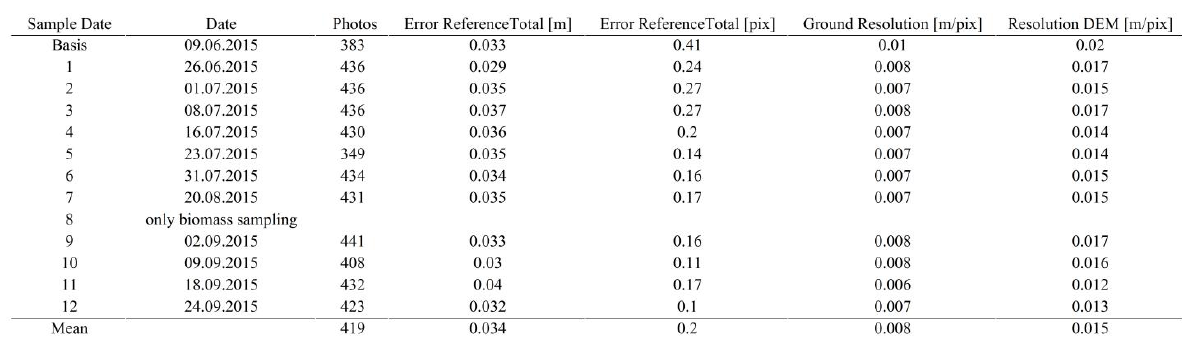
Table 1. Overview of number and features of photos of all sample